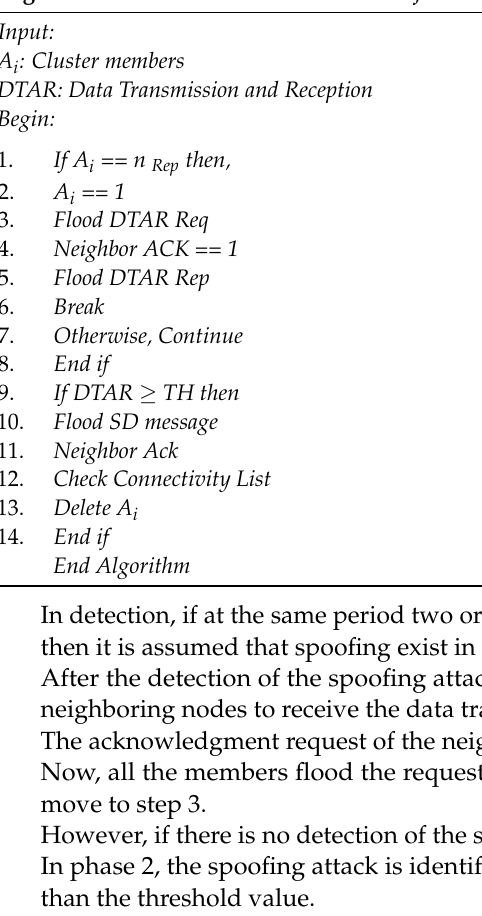
Algorithm for the Detection and Identification of Spoofing Attack